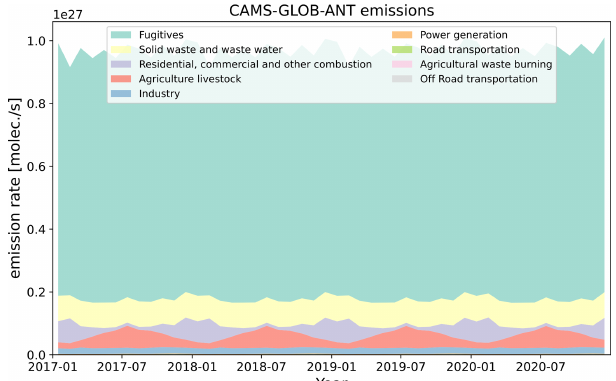
Figure 1. Stacked area plot for different sectors of the monthly averaged CAMS global anthropogenic emissions ( > 1 × 10 20 molec.s − 1 ) in the USCB region for 2017–2020 (https:// permalink.aeris-data.fr/CAMS-GLOB-ANT, last access: 22 De- cember 2021, Granier et al.,